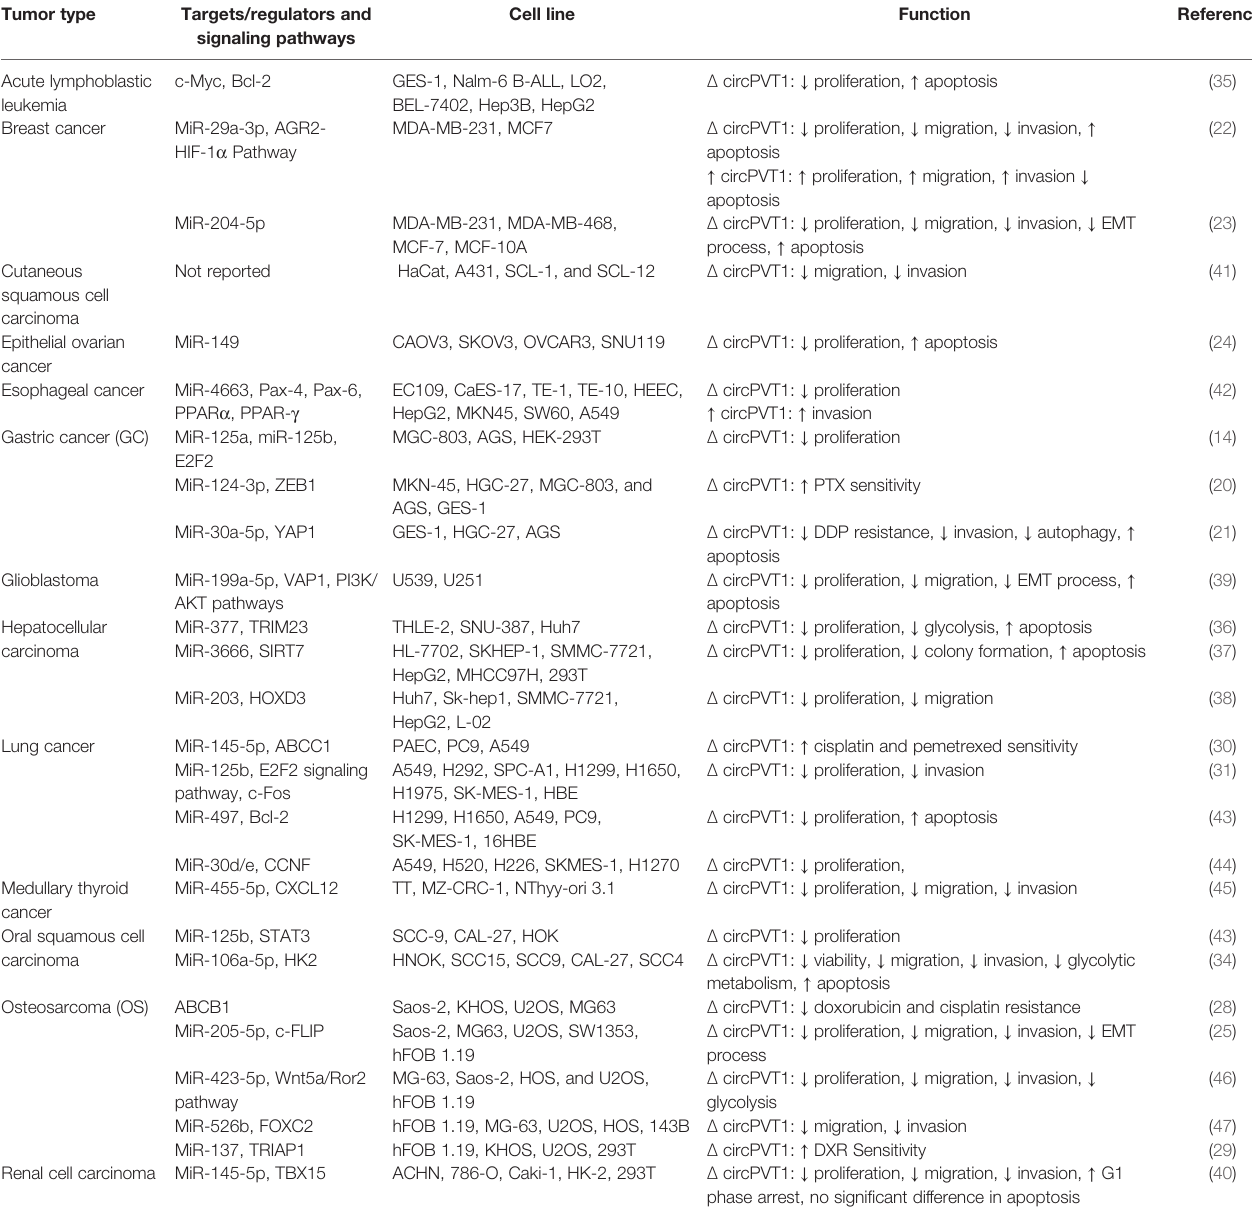
TABLE 1 | Impact of circPVT1 carcinogenesis based on cell line